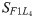
Automatic image analysis begins by calculating the overlapping volume of each structure in Frame 1 with each structure in Frame 2.Vxy refers to the number of voxels that overlap between structure x in Frame 1 and structure y in Frame 2. Where x = 0 or y = 0 refers to the background. Using matrix V, the labelled structures that are associated with each other both between Frames 1 and 2, as well as within the same frame, can be calculated. The relationships are encoded as arrays of lists, where each list is related to the labelled structure corresponding to the array index. Therefore, the 8th list in the array relates to labelled structure number 8. F2L8 refers to label number 8 in Frame 2 that is associated with the structure at the array index. Next, the relative percentage of overlap (e.g. %F2L8) is calculated for the associated structures between the frames, and is interpreted in conjunction with A1 and A2. The midway points (e.g. p4) and distances (e.g. d4) between two structures within the same frame are calculated, and are interpreted in conjunction with W1 and W2. Using these arrays of lists, the status (e.g. SF1L4) of fission, fusion, depolarisation or no event can be determined for each mitochondrial structure. Finally, the event can be overlaid on the original z-stack at the location of the midway points.